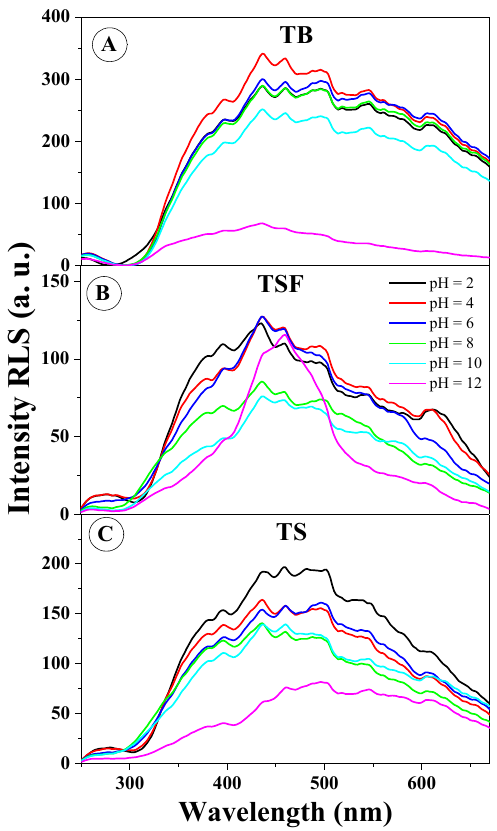
Figure 6. Resonance light scattering spectra (RLS) of ( A ) TB, ( B ) TSF, and ( C ) TS dissolved in H 2 O in different pH.